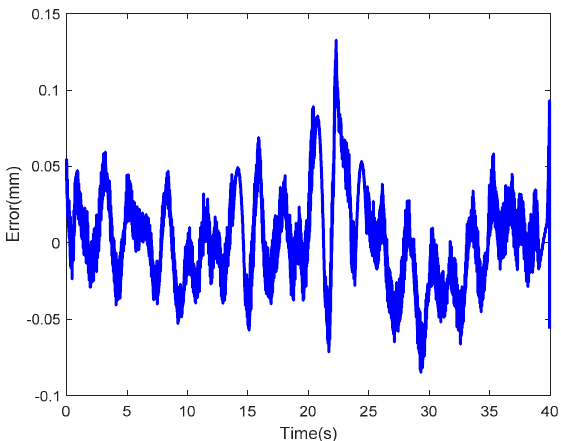
Figure 51. Control error at random sine input displacement. Figure 50. Control error at random sine input displacement.